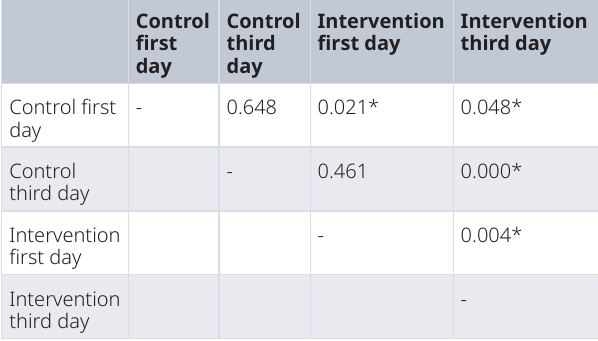
Table 3. Mann–Whitney results of CRP levels in the saliva of the control and intervention groups.